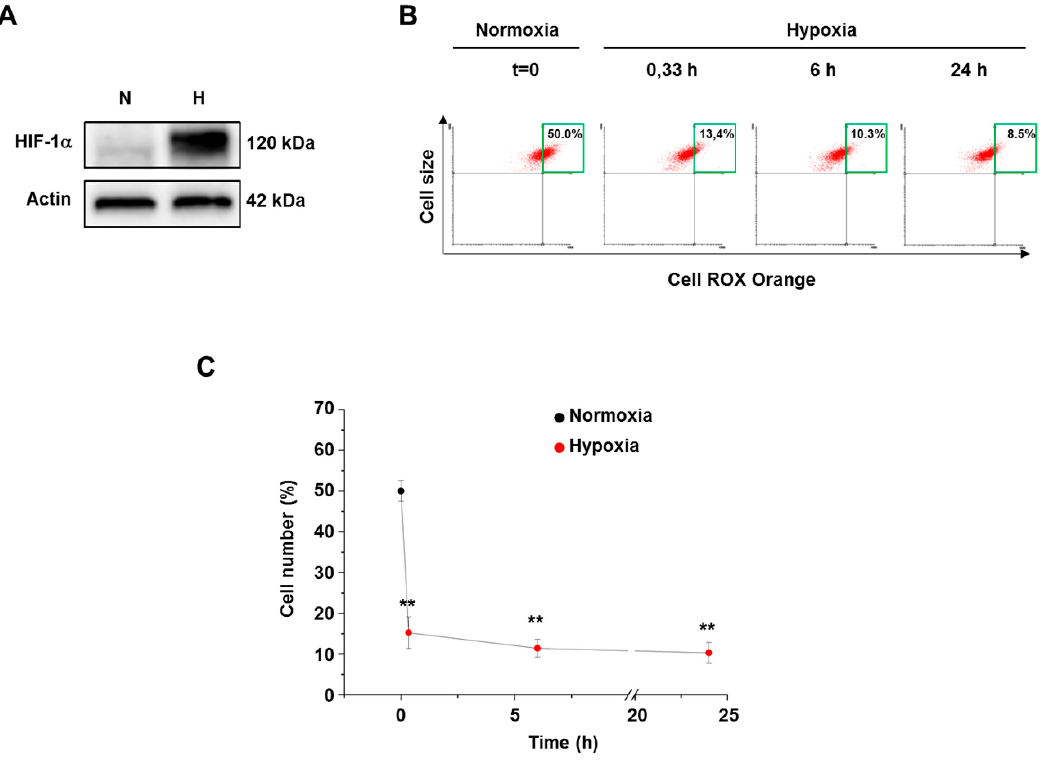
Figure 3. ROS level in osteosarcoma cells grown under hypoxia. ( A ) HIF-1 α level determined upon 6 h exposure of osteosarcoma cells to either normoxia or hypoxia. ( B ) Representative top right quadrant analysis of CellROX-loaded cells maintained in either normoxia or hypoxia (0.5% O 2 ) up to 24 h. ( C ) Scatter graph showing the time-dependence of cellular ROS level decrease during 24 h hypoxic exposure. Data are means ± SD of three independent experiments. ** p ≤ 0.01 indicates the statistical significance of data compared to normoxia.